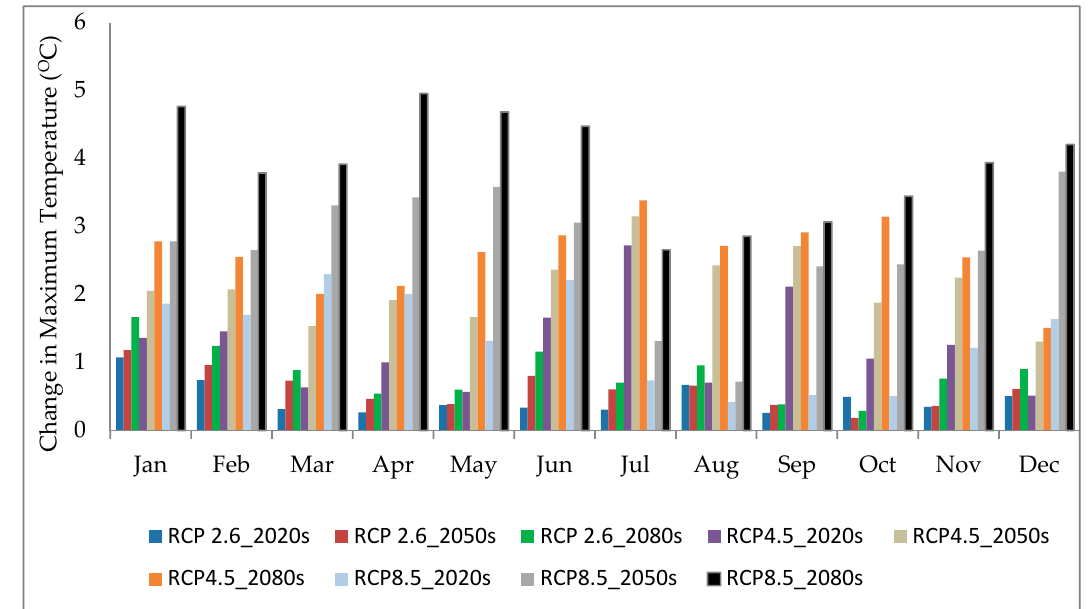
Figure 10. Change in monthly average maximum temperature compared to the baseline period (1961–1990).